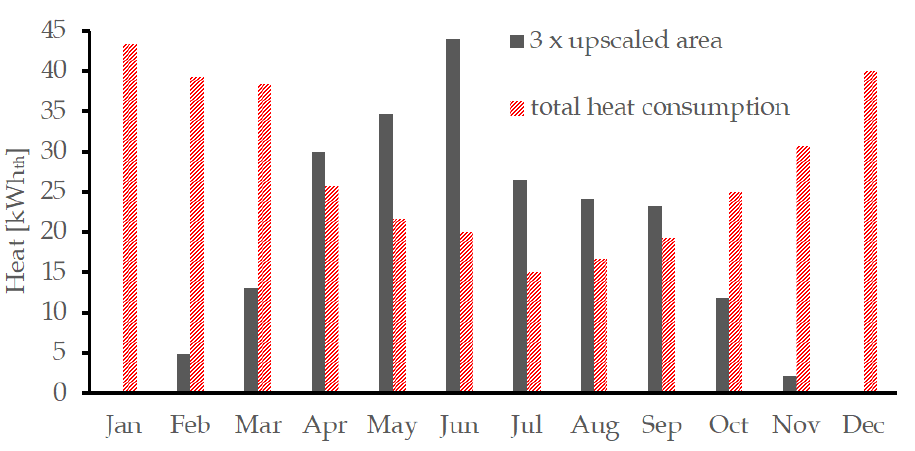
Figure 8. 3x upscaled area daily production of solar heat compared with statistical data on energy consumption